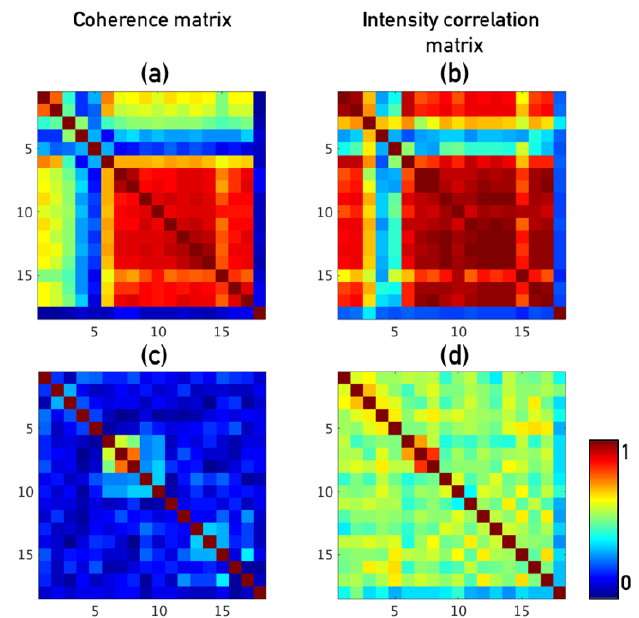
Figure 11. Comparison between coherence matrix and intensity correlation matrix at ( a , b ) intermediate coherence (0.47) and ( c , d ) low coherence (0.12).